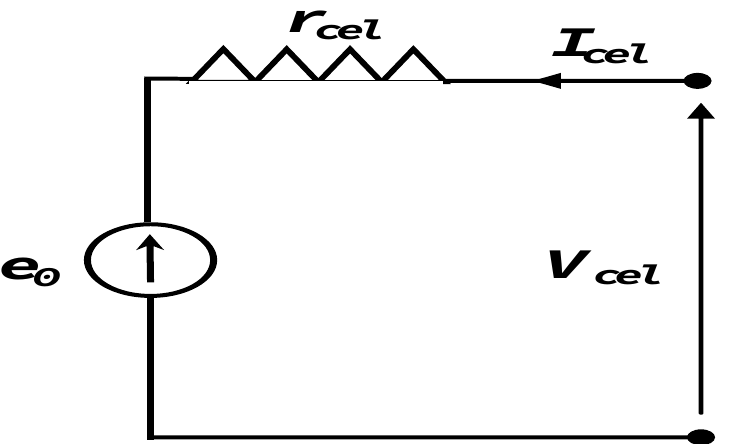
Figure 11. Equivalent electrical diagram of an elementary battery cell.